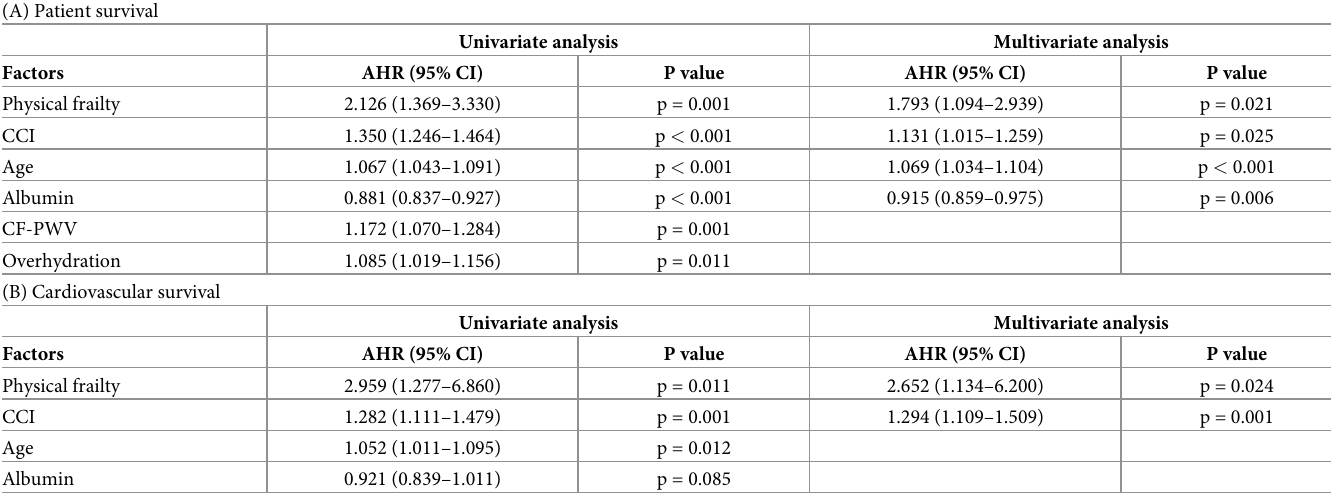
Table 3. Univariate and multivariate Cox regression